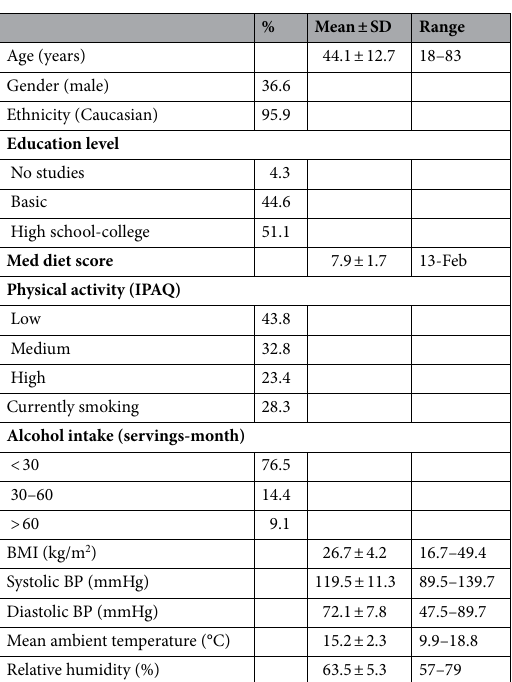
Table 1. Baseline characteristics of the study population (1103 individuals without HT at